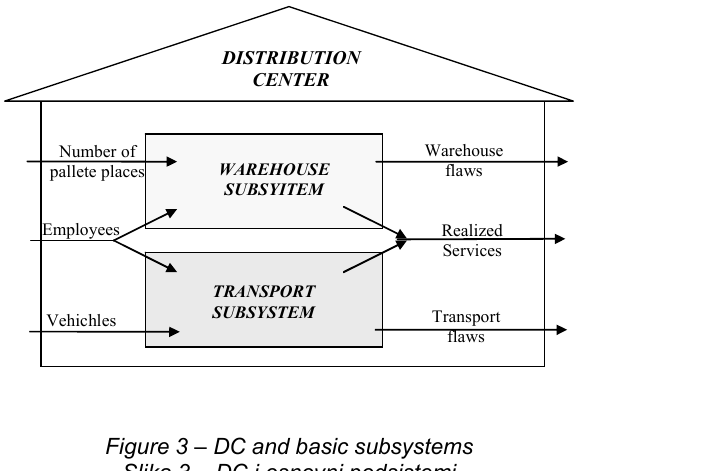
Figure 3 – DC and basic